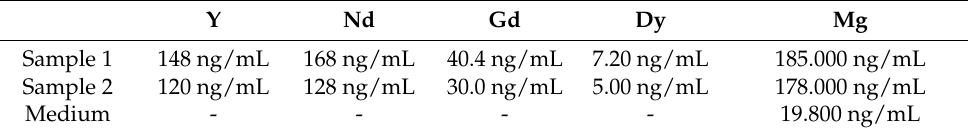
Table 7. Concentration of elements in extracts and pure medium (ICP-MS). Y